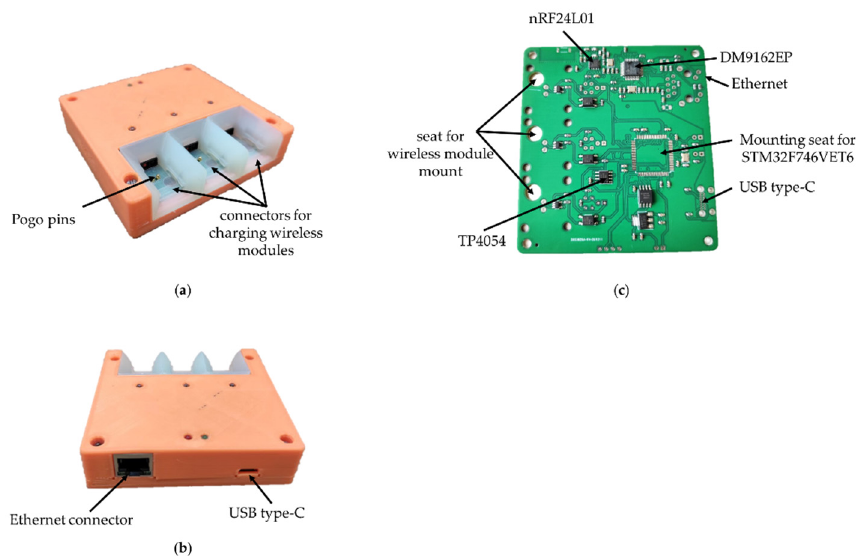
Figure 7. Base station of the electrophysiological complex in 3D printed housing: ( a ) front view; ( b ) back view; ( c ) base station PCB with soldered components. Table 3. Main components of the base